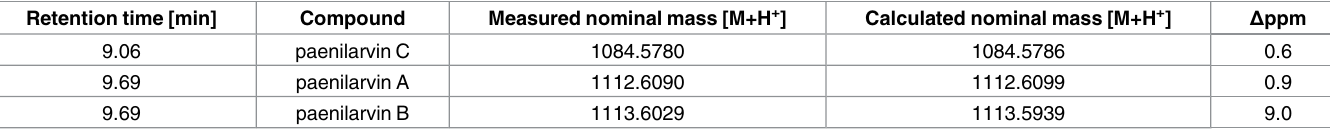
Table 1. Measured and calculated nominal masses,corresponding retention times [min] and mass errors ( Δ ppm) of the paenilarvins A, B, and C detected in infected larvae. Retention time